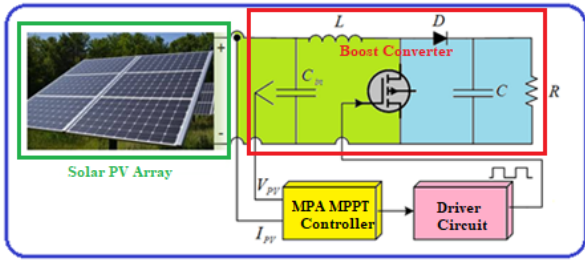
Figure 1. Photovoltaic (PV) system block diagram.